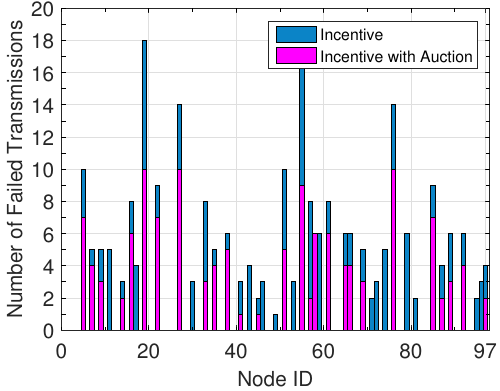
Figure 5. Distribution of the failed transmissions.